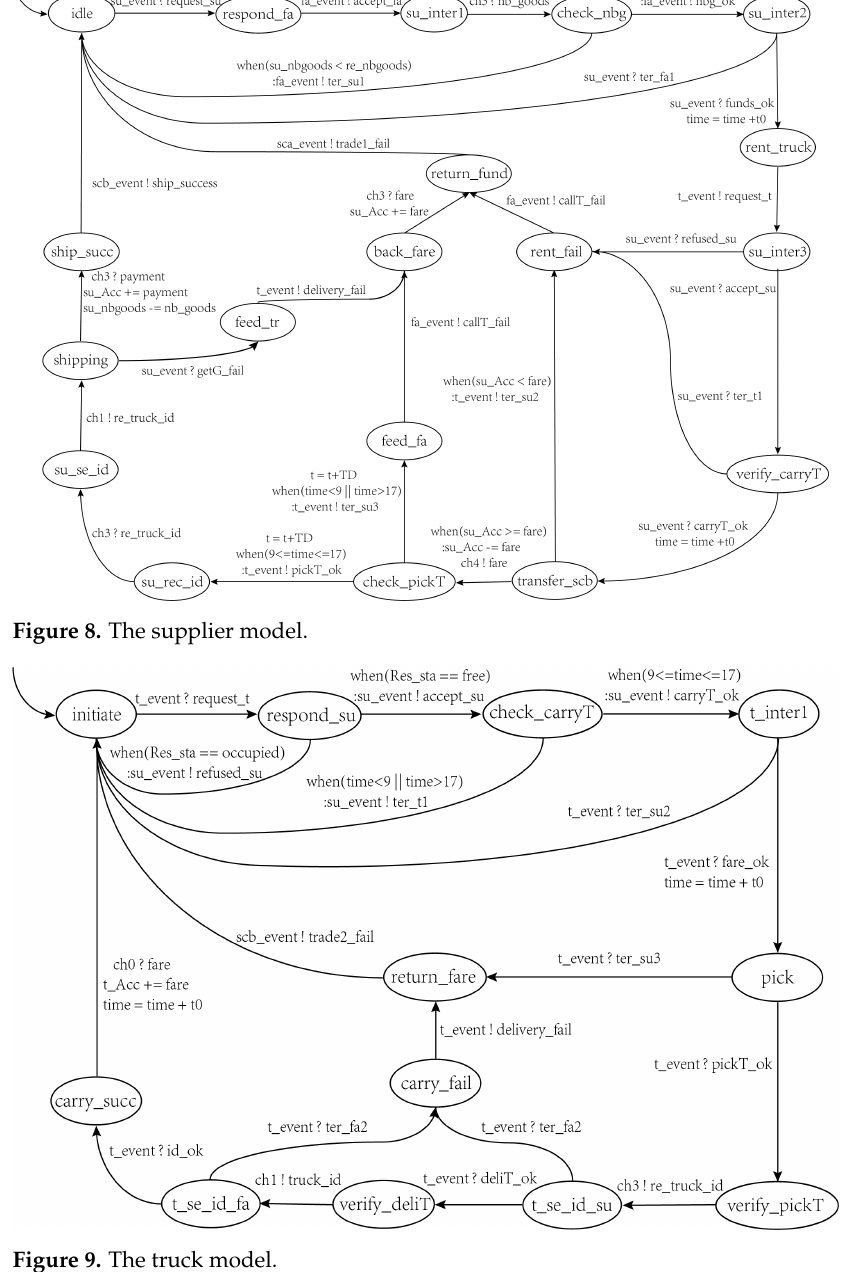
Figure 9. The truck